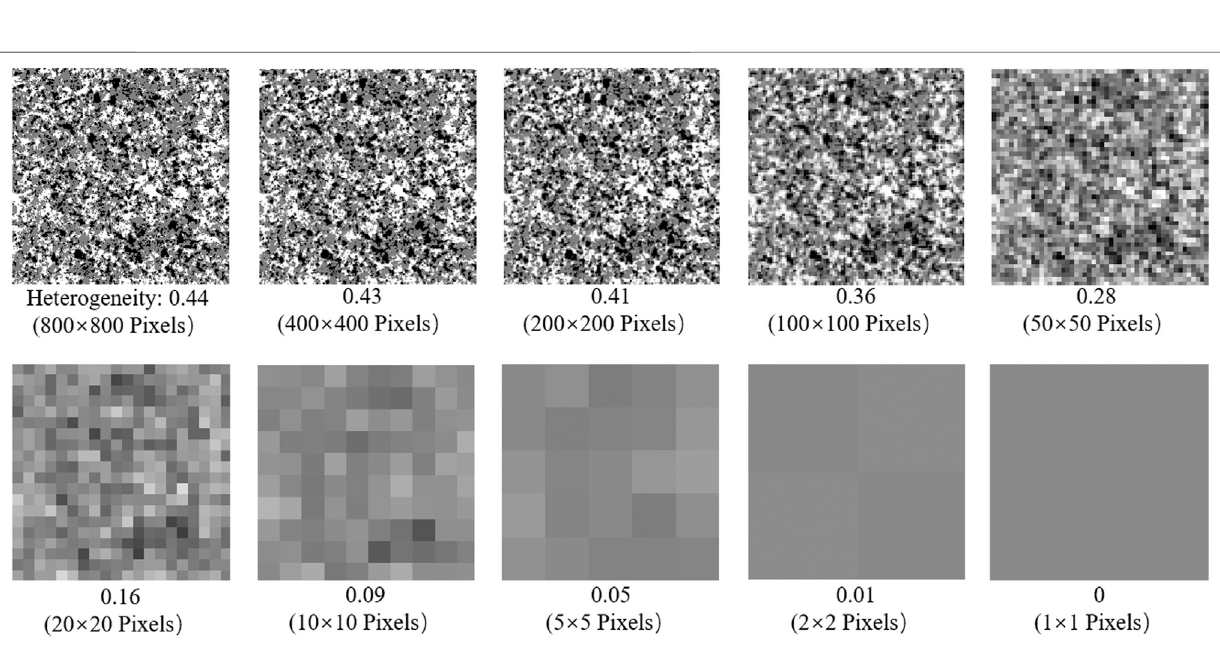
Frontiers in Earth Science |